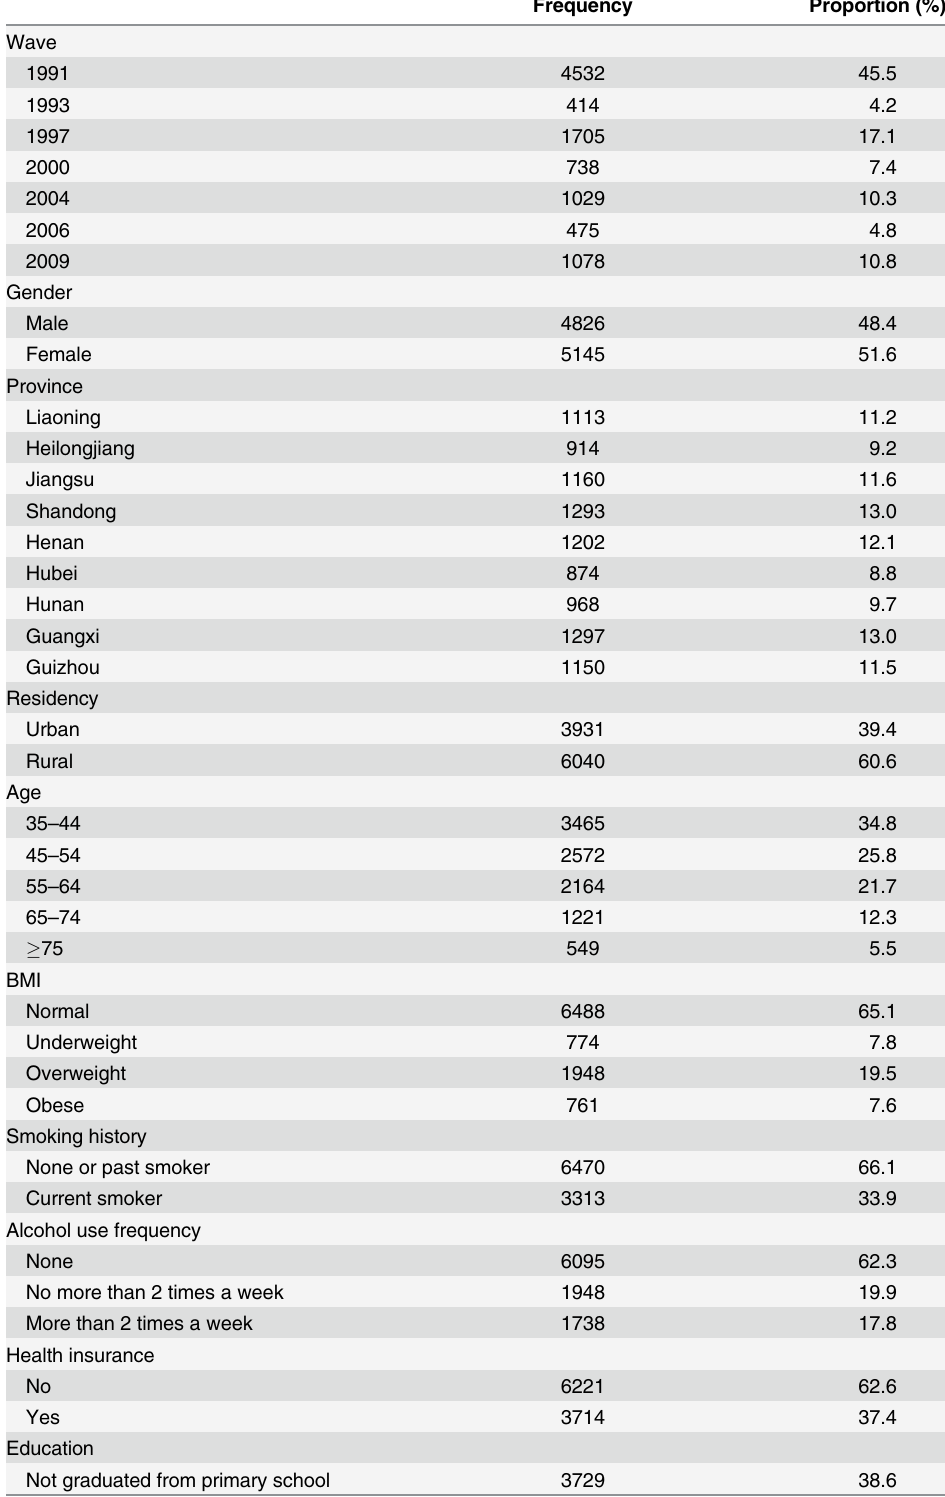
Table 1. Demographic and socio-economic properties of the